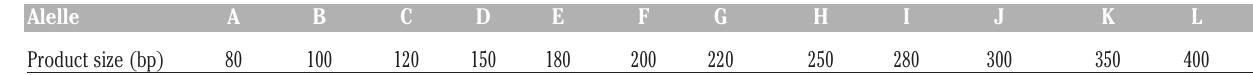
Table 1. Types and size of alleles from genomic DNA of 12 sampled superior cotton varieties. Alelle